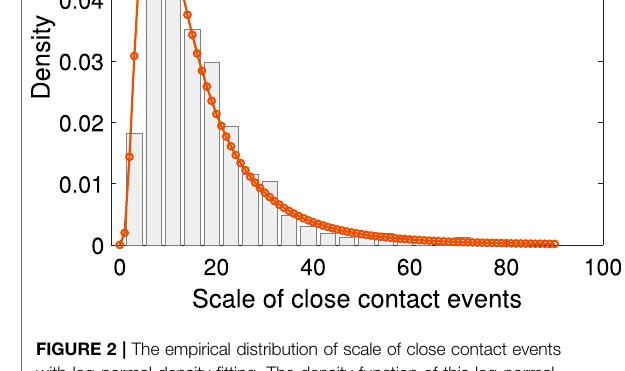
FIGURE 2 | The empirical distribution of scale of close contact events with log-normal density fi tting. The density function of this log-normal (cid:6)(cid:6) √ e − ( ln x − μ ) 2 2 σ 2 , where the fi tting parameters are distribution is f LN ( x ) (cid:1) 1 σ x 2 π μ (cid:1) 2 . 495, σ (cid:1) 0 . 745. The p -value of the K – S test for log-normal distribution is 0.18. The notion that the scale is log-normal distributed is not